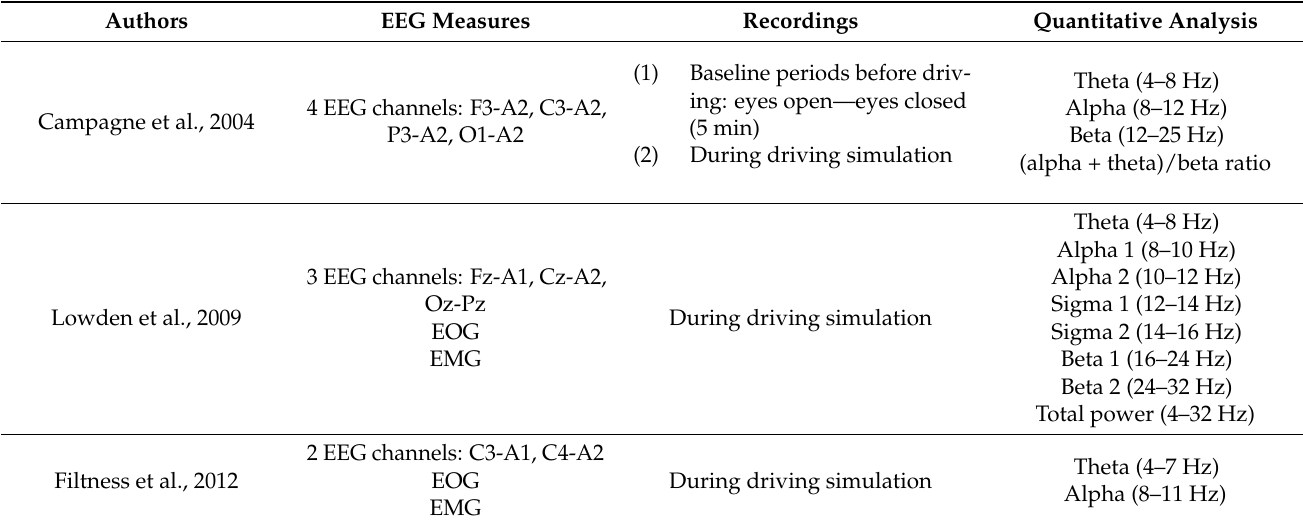
Table 2. Characteristics of electroencephalographic